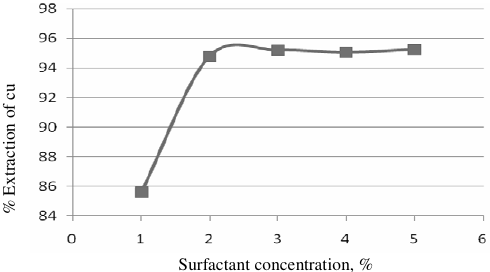
Figure 1. Effect of surfactant concentration to extraction percentage of Cu(II).